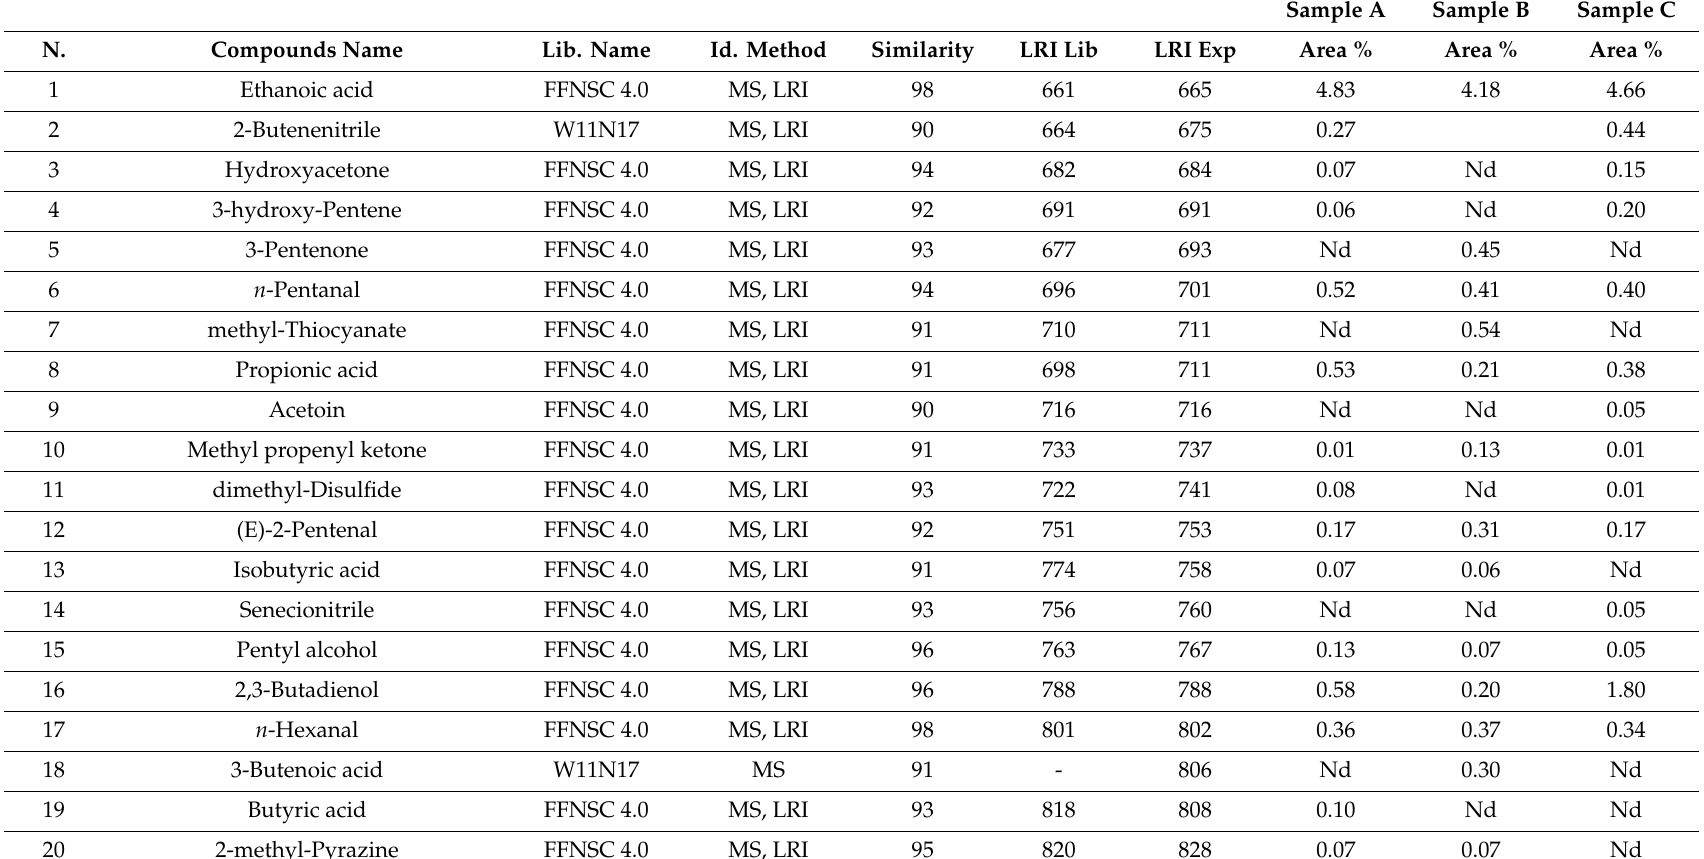
Table 3. Quantitative determination by GC-FID of the chemical components of the leaves of the three Brassica accessions investigated. FFNSC: Flavor and Fragrance Natural and Synthetic Compounds; LRI: Linear Retention